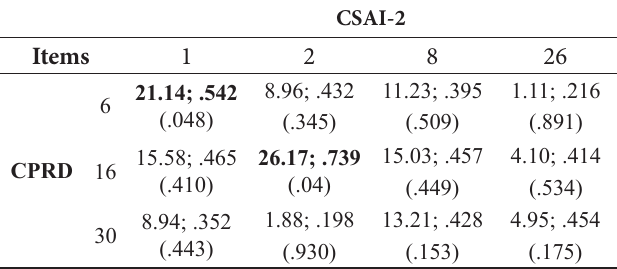
Table 8. Correlation of CSAI-2 and CPRD items on the variable anxiety.